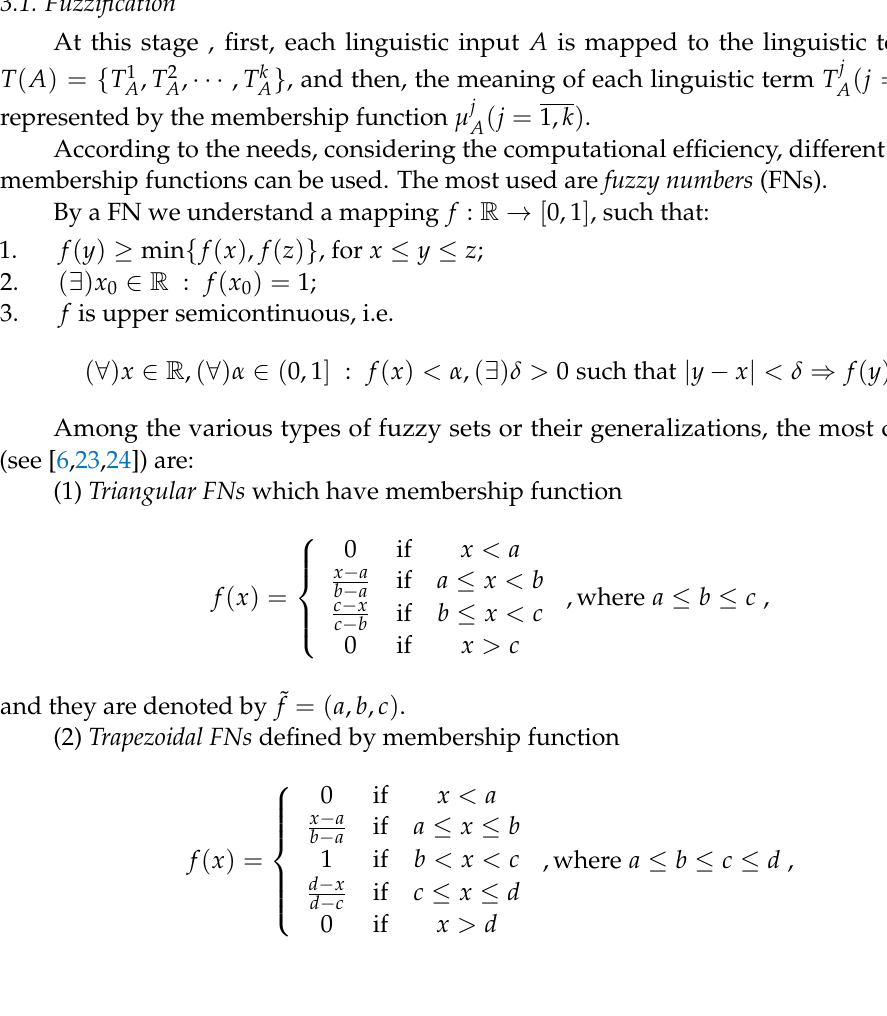
Figure 2. The structure of a fuzzy logic system.